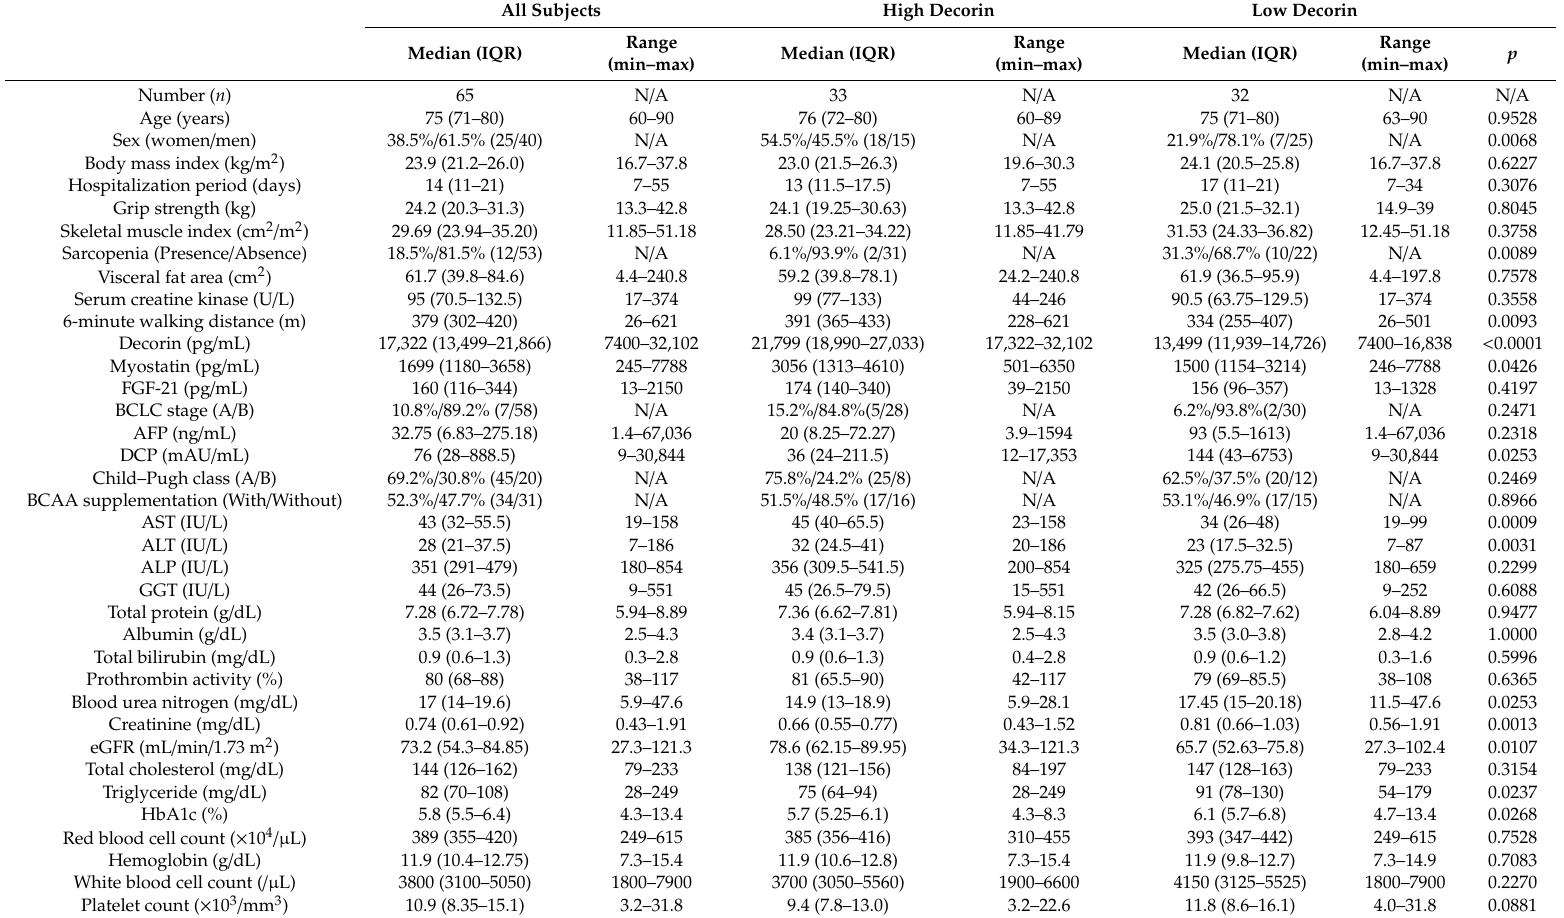
Table 1. Patients’